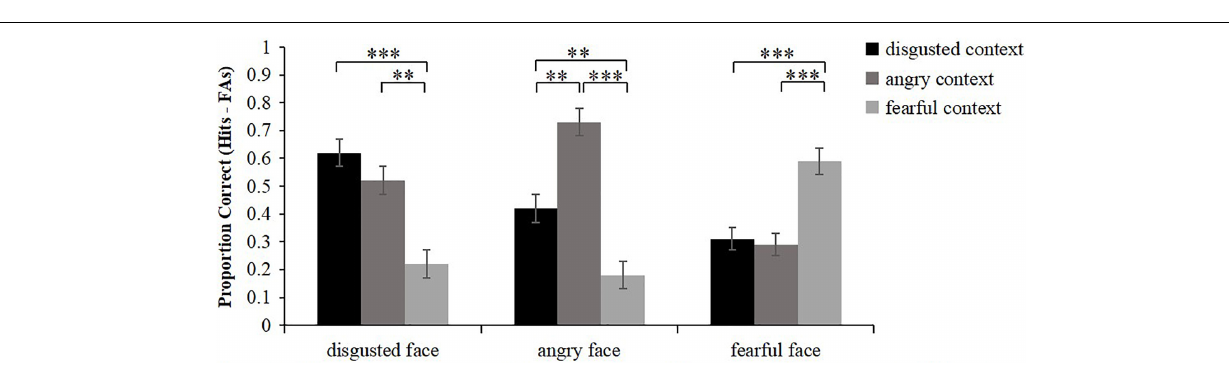
FIGURE 3 | Mean proportion correct for recognition of the associated intact context (hits minus false alarms) as a function of emotional face and emotional context. Error bars represent standard error. ∗∗ p < 0.01, ∗∗∗ p <